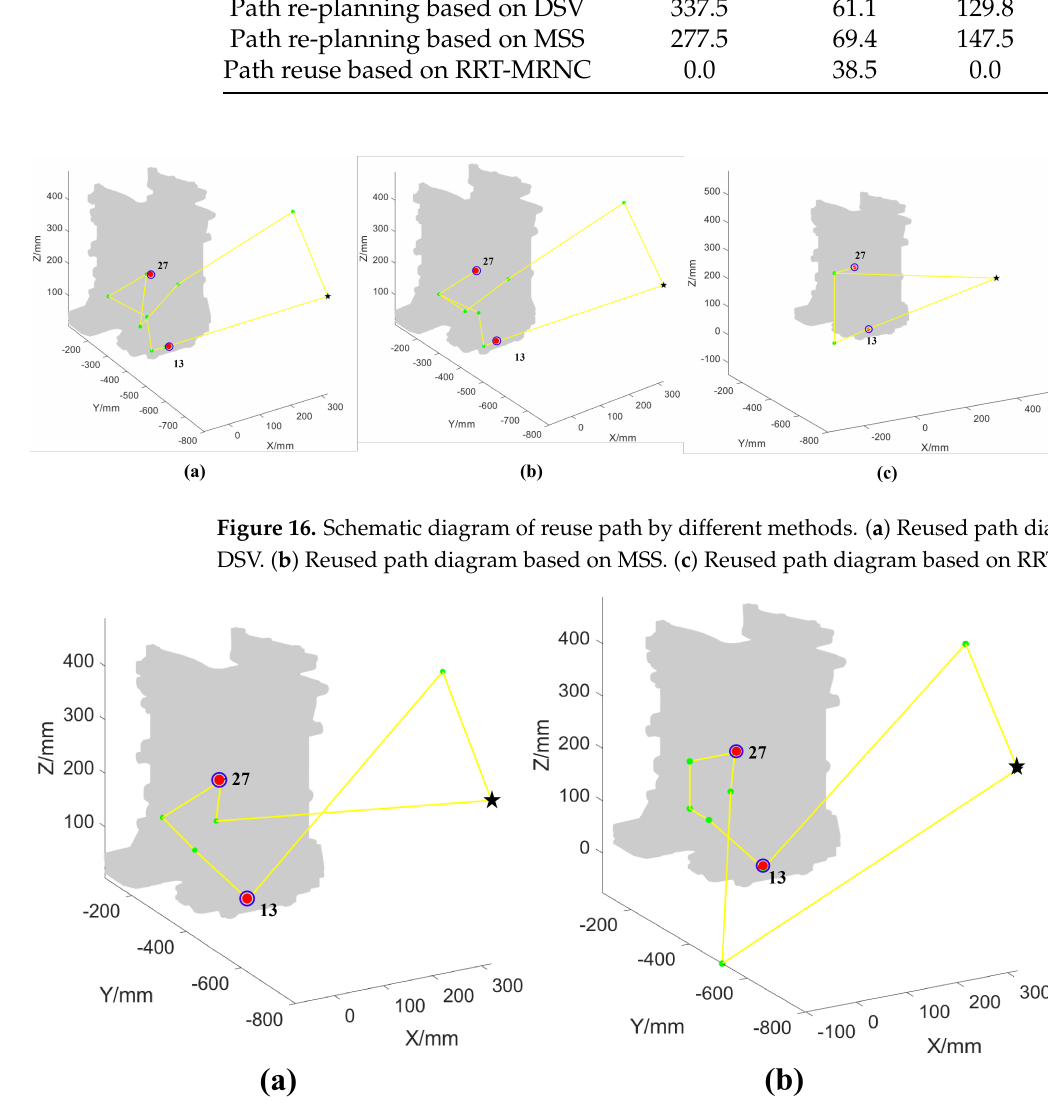
Figure 17. Schematic diagram of re-planning path by different methods. ( a ) Re-planning path diagram based on DSV. ( b ) Re-planning path diagram based on